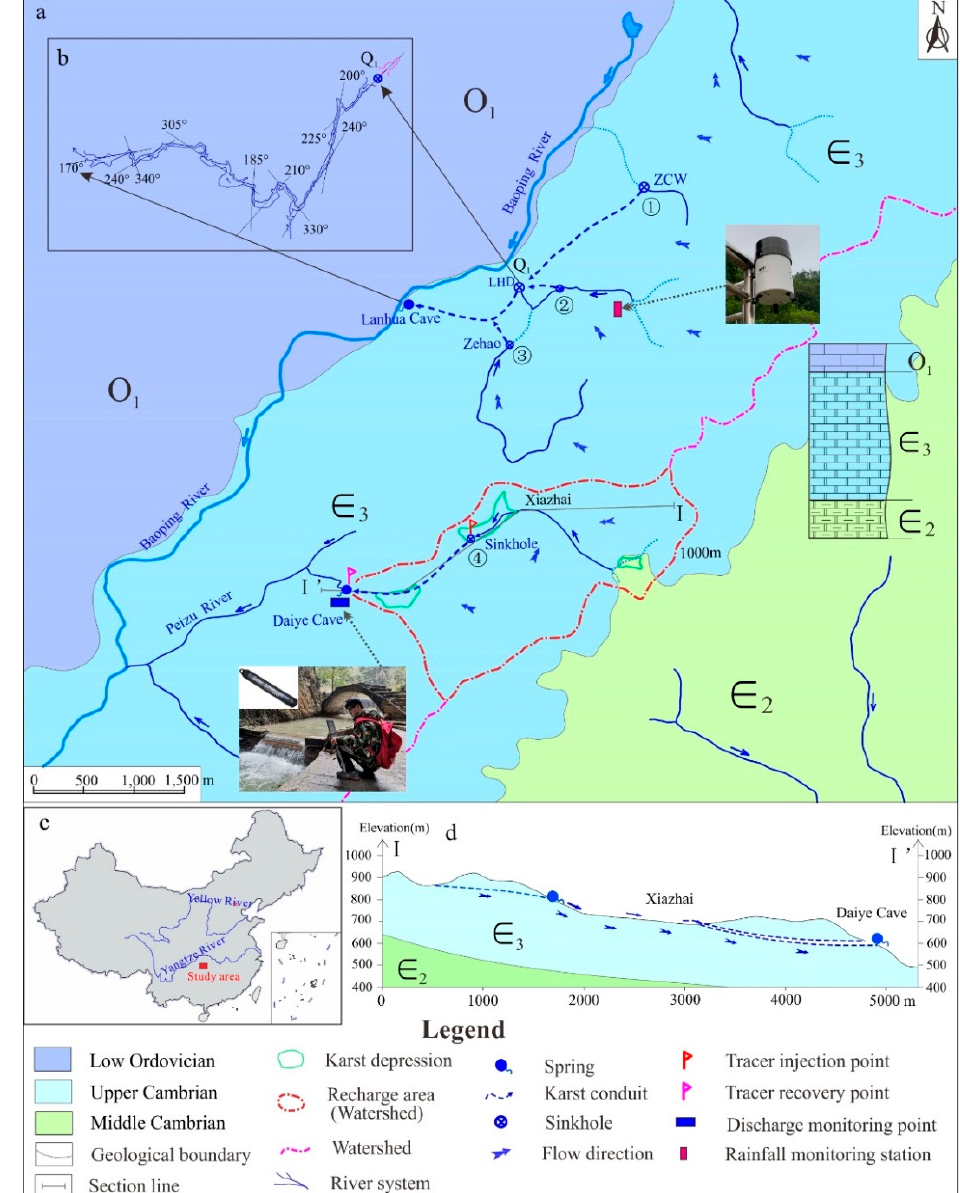
Figure 1. ( a ). Hydrogeological map of study area; ( b ). Measured underground river direction map; Figure 1. ( a ) Hydrogeological map of study area; ( b ) Measured underground river direction map; ( c ) ( c ). Location of the study site in China; ( d ). Schematic geological-hydrogeological cross section of Location of the study site in China; ( d ) Schematic geological-hydrogeological cross section of the I–I’ the I–I’ line shown in ( a ). line shown in ( a